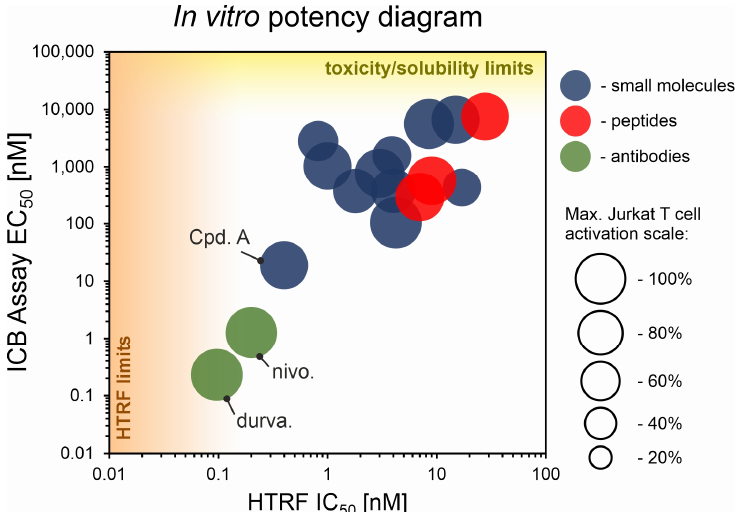
Figure 1. The correlation of IC 50 values from the HTRF assay and EC 50 values from the ICB assay for representative molecules belonging to various classes: blue—small molecules; red—peptides; green—antibodies. Each bubble represents a separate PD-L1-targeted molecule listed in Table 1. The size of the bubble indicates the % of the maximal activation of effector Jurkat T cell in the ICB assay, achieved for a therapeutic anti-PD-L1 antibody. “HTRF limit” indicates a bottom limit of IC 50 determination with HTRF (related to the concentrations of targeted PD-1 and PD-L1 proteins). “Toxicity/solubility limits” indicate the upper limits of EC 50 determination in the ICB assay (related to toxicity towards the cells and limited water solubility of the molecules). See Appendix A for further explanations. Durva., durvalumab; nivo., nivolumab; Cpd. A, compound A. Table 1. The list of representative PD-L1 inhibitors belonging to various classes and their PD-L1 blockade characteristics. IC 50 values were determined with the HTRF assay and EC 50 values were determined with the ICB assay. %RLU max indicates the maximal activation of Jurkat T cells in the ICB assay, calculated as the % of the activation achieved for therapeutic anti-PD-L1 antibody (atezolizumab or durvalumab). When available, the data on the in vitro PD-L1 dimerization in the presence of the molecule, and the species specificity (human PD-L1, h PD-L1, and mouse PD-L1, m PD-L1) are indicated. √ “ ”, particular activity confirmed experimentally; “No”, the compound was confirmed not to possess a particular activity; “n.d.”, no data on a particular activity.